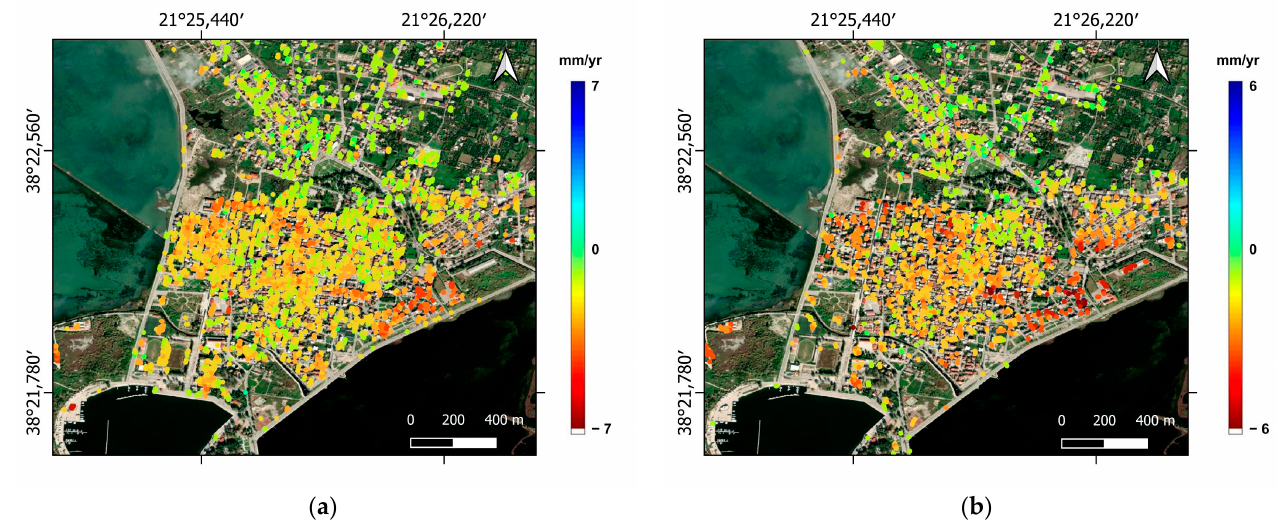
Figure 10. Spatial distribution of the Sentinel-1 vertical deformations in Messolonghi for ( a ) the descending satellite pass (no. 80) & ( b ) the ascending satellite pass (no. 175). Both coming from the P-PSI satellite data analysis conducted at BEYOND.